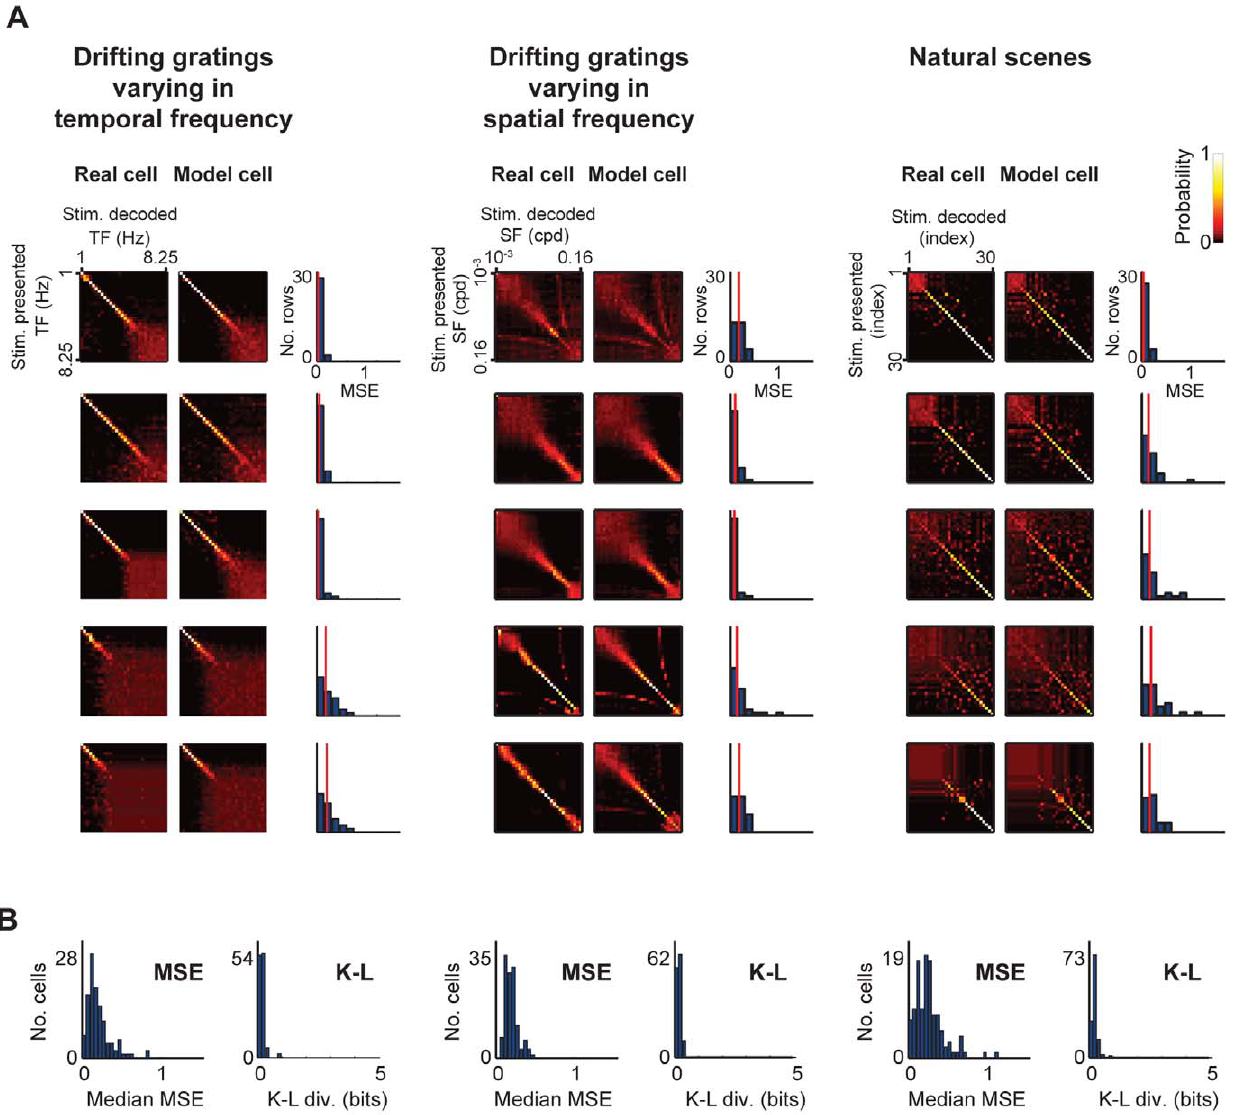
Figure 4. The posterior stimulus distributions of the model cells closely matched those of their real cell counterparts. ( A ) Pairs of matrices for each cell. The matrix on the left gives the posterior stimulus distributions for the real cell’s responses; the matrix on the right gives the same for the model cell’s responses. The histogram next to the pair gives a measure of the distance between them. Briefly, for each row, we computed the mean squared error (MSE) between the model’s posterior and the real cell’s posterior and then normalized it by dividing it by the MSE between the real cell’s posterior and a randomly shuffled posterior. A value of 0 indicates that the two rows are identical. A value of 1 indicates that they are as different as two randomly shuffled rows. Because of data limitation, occasional cells showed values higher than 1. The vertical red line indicates the median value of the histogram, the MSE a value. ( B ) Histogram of the MSE a values for all cells in the data set, and histogram of the K-L a values for all cells in the data set ( n =109, 120 and 113 cells for the stimuli, respectively). As shown in these histograms, most of the distances are low. For the MSE, the median a value is 0.21. As mentioned above, 0 indicates a perfect match between model and real responses, and 1 indicates correspondence no better than chance. For the K-L divergence, the median a value is 0.18. As a reference, 0 indicates a perfect match between model and real responses, and 4.9 bits (the stimulus entropy) indicates a poor match – this would be the K-L divergence between perfect decoding by a real cell and random decoding by a model cell. The complete set of matrices for the data set are provided in Figs. S1, S2,